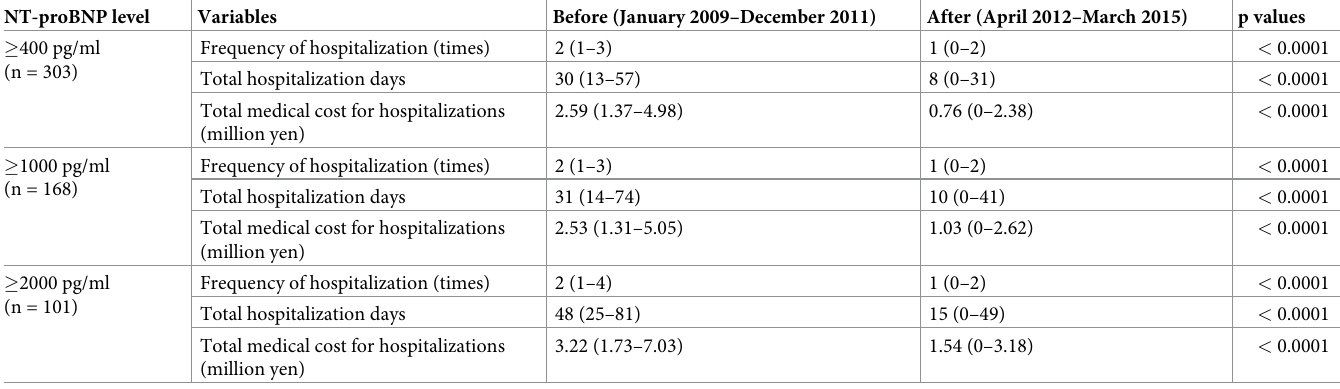
Table 4. Hospitalizations of pHF-positive patients before and after the start of team approaches for HF patients. NT-proBNP